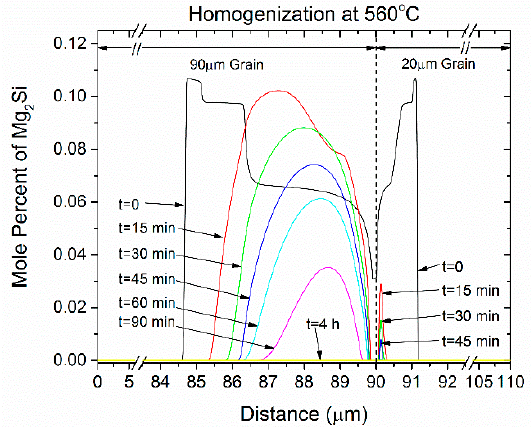
Figure 6. Evolution of spatial distribution of the mole percent of Mg 2 Si at various times during the homogenization of 6082 alloy at 560 °C.